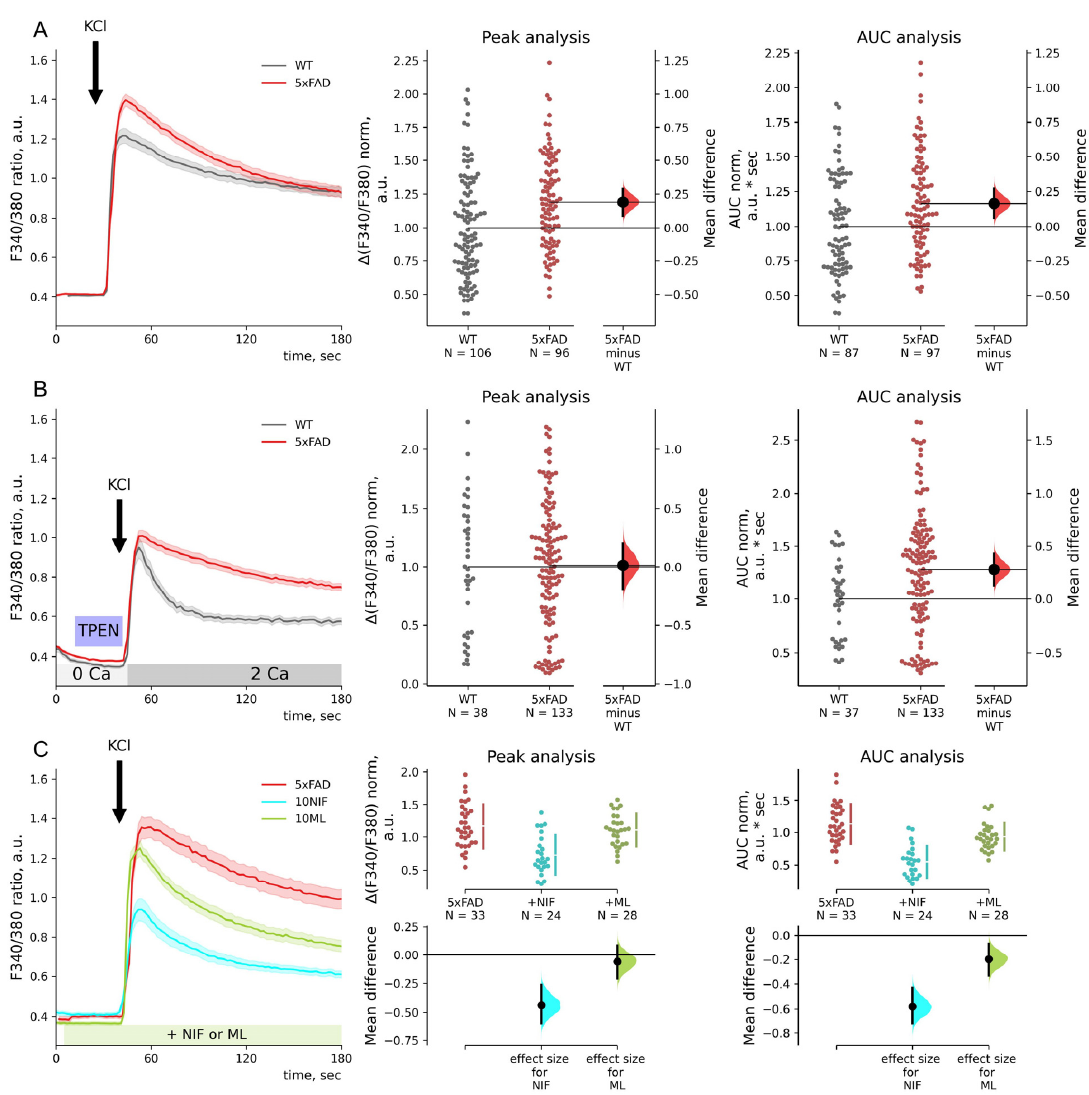
Figure 4. In hippocampal neurons, voltage-gated calcium entry is sensitive to intracellular calcium stores. ( A – C ) Calcium imaging with Fura2 of neurons of primary hippocampal cultures of wild-type (WT, gray) and 5xFAD mice. Mean traces of F340/380 ratio are represented as mean ± SEM. 50 mM KCl (KCl) was added to induce depolarization. Calcium entry ( Δ F340/F380) was calculated as the F340/F380 peak of each trace after KCl application, and the baseline was subtracted. Areas under the curve (AUC) were calculated for 40 sec after KCl applications. Δ F340/F380 and AUC data are normalized by the mean WT neuron values and shown in separate estimation plots. The estimation plots have normalized data plotted on the upper axes and mean differences plotted on floating axes on the bottom as a bootstrap sampling distribution. ( A ) The mean difference between KCl-induced calcium entry in WT and 5xFAD neurons is 0.19 for amplitudes and 0.17 for AUC values; p = 1.6 × 10 − 4 and 0.002, Mann–Whitney test. ( B ) Calcium stores were depleted with 1 mM chelator TPEN for 20 sec before KCl application. The mean difference between KCl-induced calcium entry in WT and 5xFAD neurons is 0.01 for amplitudes and 0.28 for AUC values; p = 0.98 and 0.006, Mann–Whitney test. ( C ) Inhibitory analysis of depolarization-induced calcium entry in 5xFAD neurons was done with the Kruskal–Wallis ANOVA ( p < 0.001 for peaks and AUC values) with post hoc Dunn’s test was implemented; pairwise p -values were calculated for untreated 5xFAD neurons. Mean differences between KCl-induced calcium entry in 5xFAD neurons and 10 μ M nifedipine or ML218-treated 5xFAD neurons are − 0.44 and − 0.06 ( p = 3.2 × 10 − 5 and 1.0) for amplitudes and − 0.58 and − 0.20 ( p = 1.9 × 10 − 9 and 0.10) for AUC values.